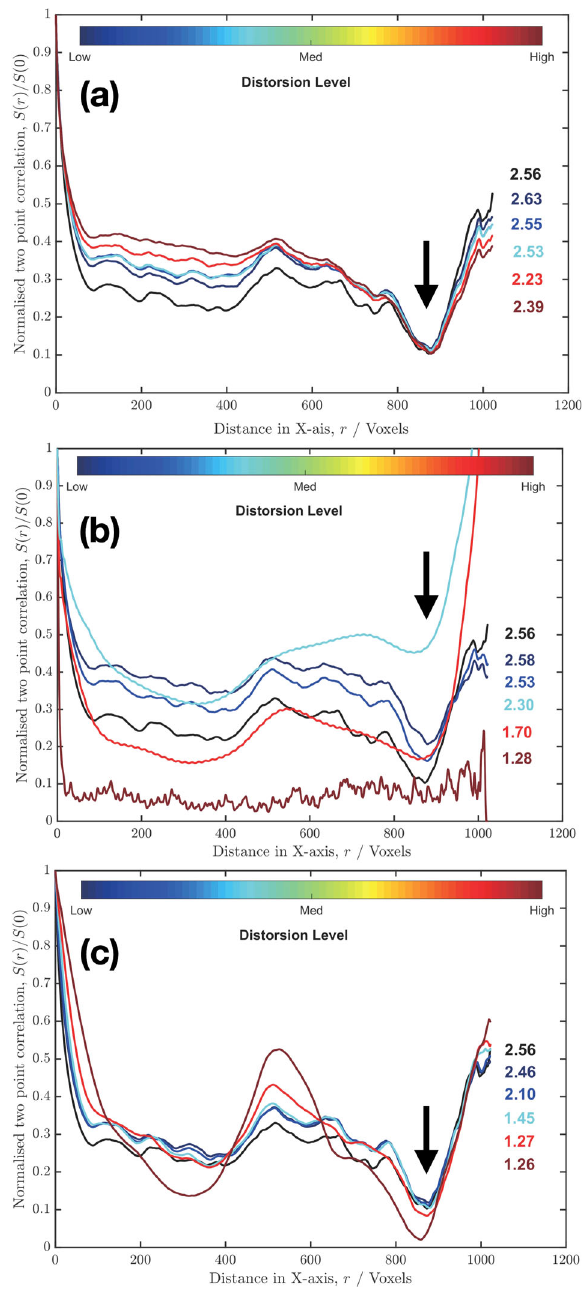
Fig. 7 Point correlation between predicted segmentation and ground truth for black phase. Figures a – c set out the correlation results from images with the ring, noise, and blur. The color bar shows the distortion at different levels, from little distortion to severe distortion. The solid line means the point correlation in X direction. The number labeled at the end of each line is the image quality